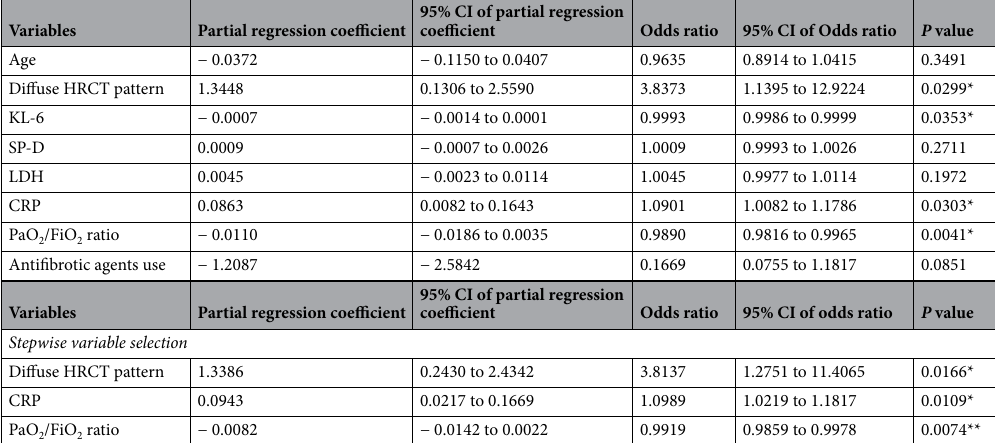
Table 2. Results of multivariate logistic regression analysis with selected variables as explanatory variables (upper) and after stepwise variable selection (lower). CI, confidence interval; HRCT, high-resolution computed